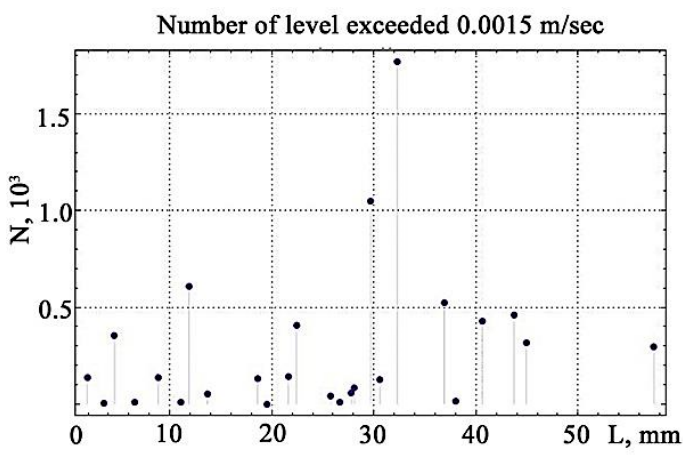
Figure 15. The total number of excess vibration amplitudes.